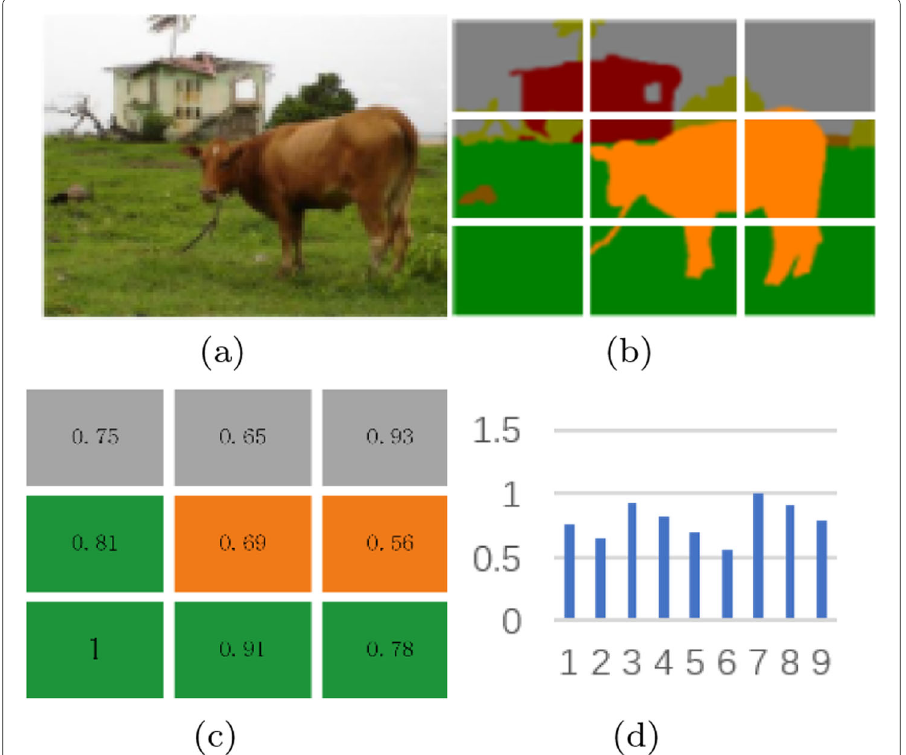
Fig. 3 Statistics of semantic